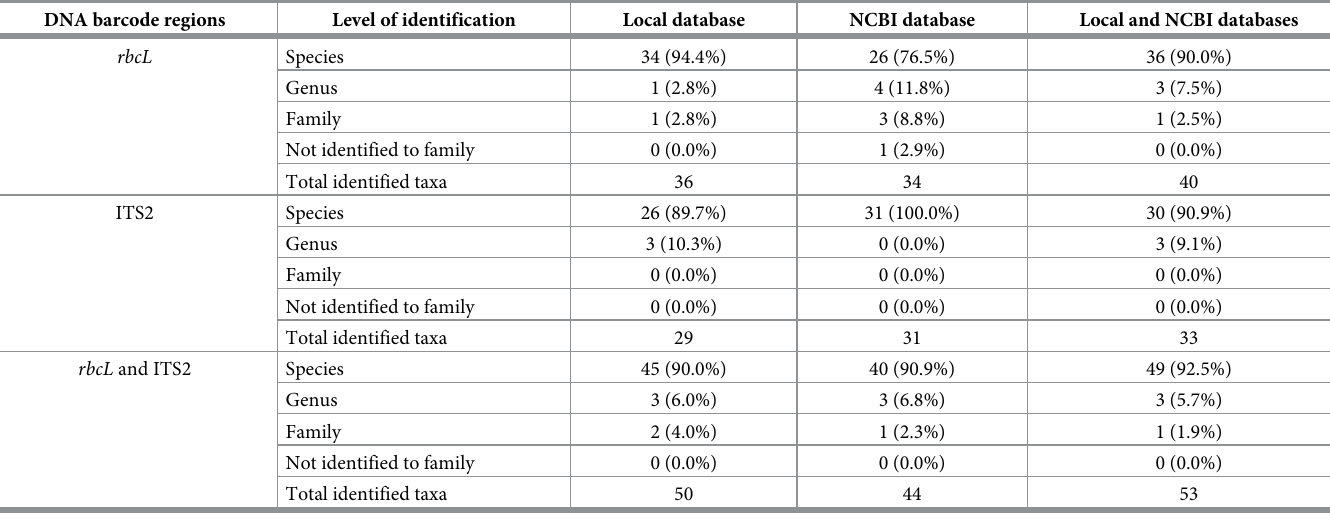
Table 3. Number of identified plant taxa and accuracy of identification based on rbcL and ITS2 sequences in different databases. DNA barcode